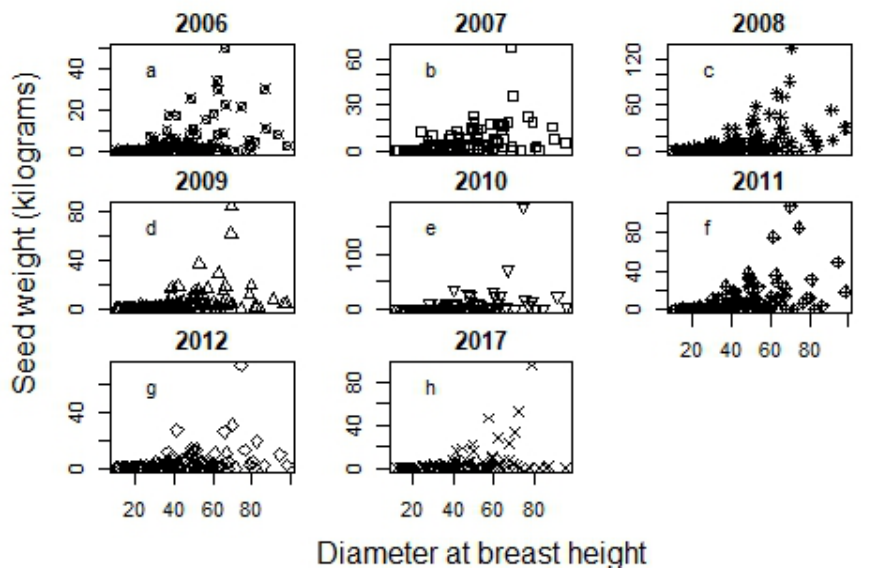
Figure 4. Annual seed production (kilograms) by Carapa guianensis diameter at breast height in Roraima, Brazil in ( a ) 2006; ( b ) 2007; ( c ) 2008; ( d ) 2009; ( e ) 2010; ( f ) 2011; ( g ) 2012; and ( h ) 2017.